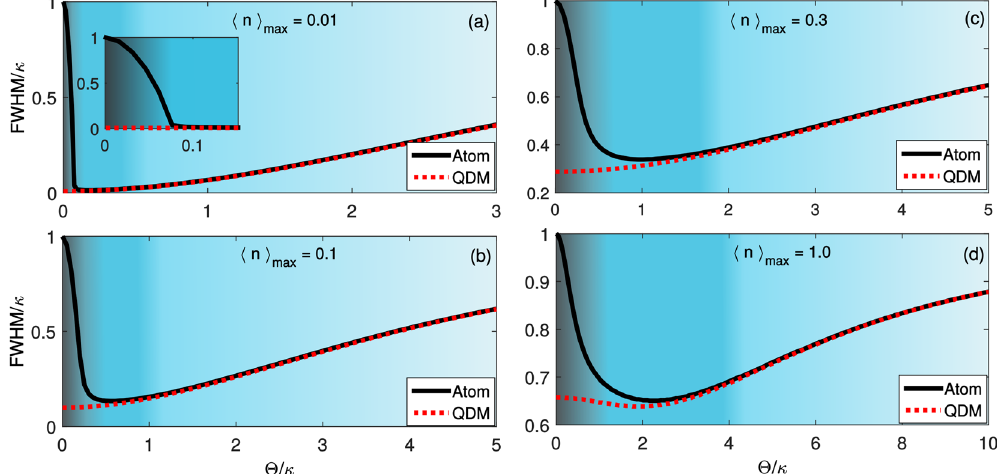
Figure 5. Full Width at Half Maximum ( FWHM ) of the dark state resonance. FWHM for the atomic (black solid line) and QDM (red dotted line) systems as a function of Θ ( = Ω C or T e ). Here assumed Γ = Γ = Γ − 10 and the other parameters are the same as those used in Fig. 4, except for ε , which implies different maximum average number of photons inside the cavity and ( d ) ε κ = . 1 0 . In some cases, the minimum FWHM for QDM becomes 10% narrower than the minimum FWHM for atomic